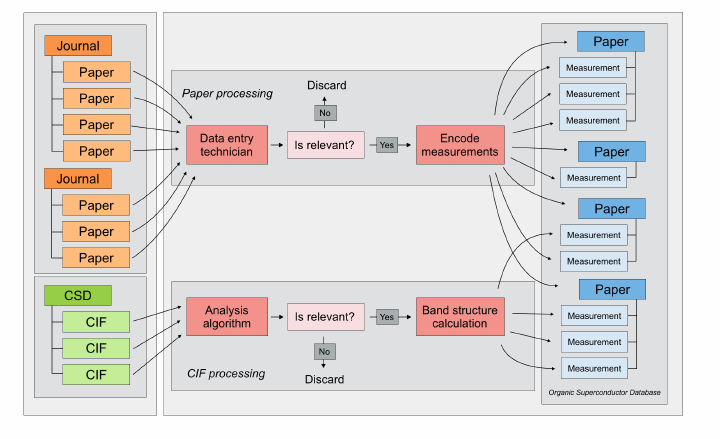
Figure 1. Diagram showing the structure and flow of information into the